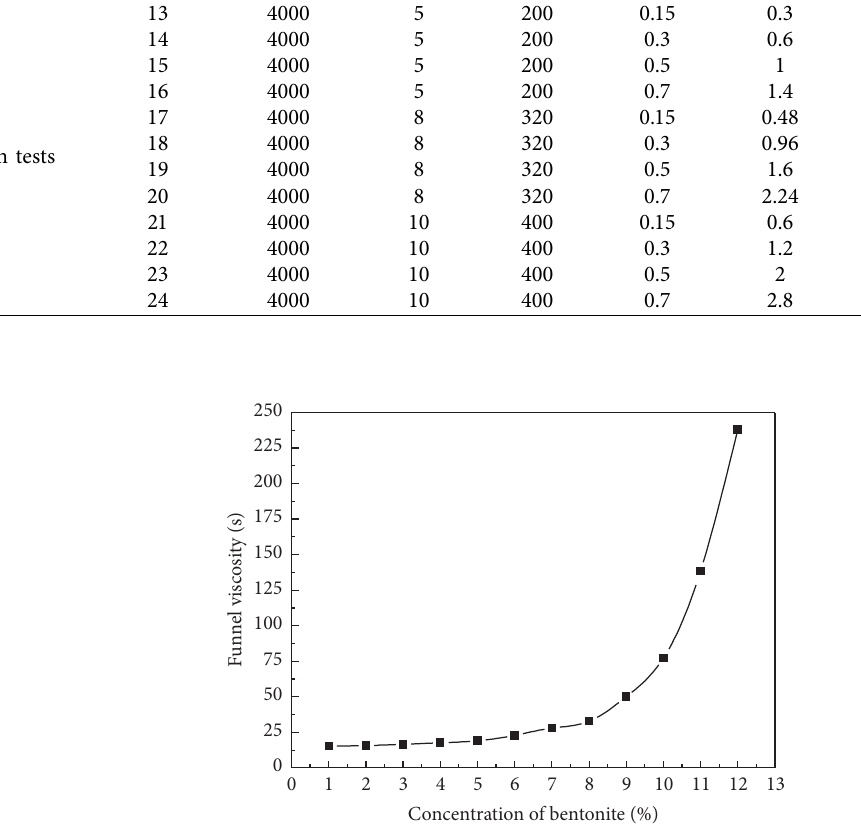
Figure 16: Effect of bentonite concentration on funnel